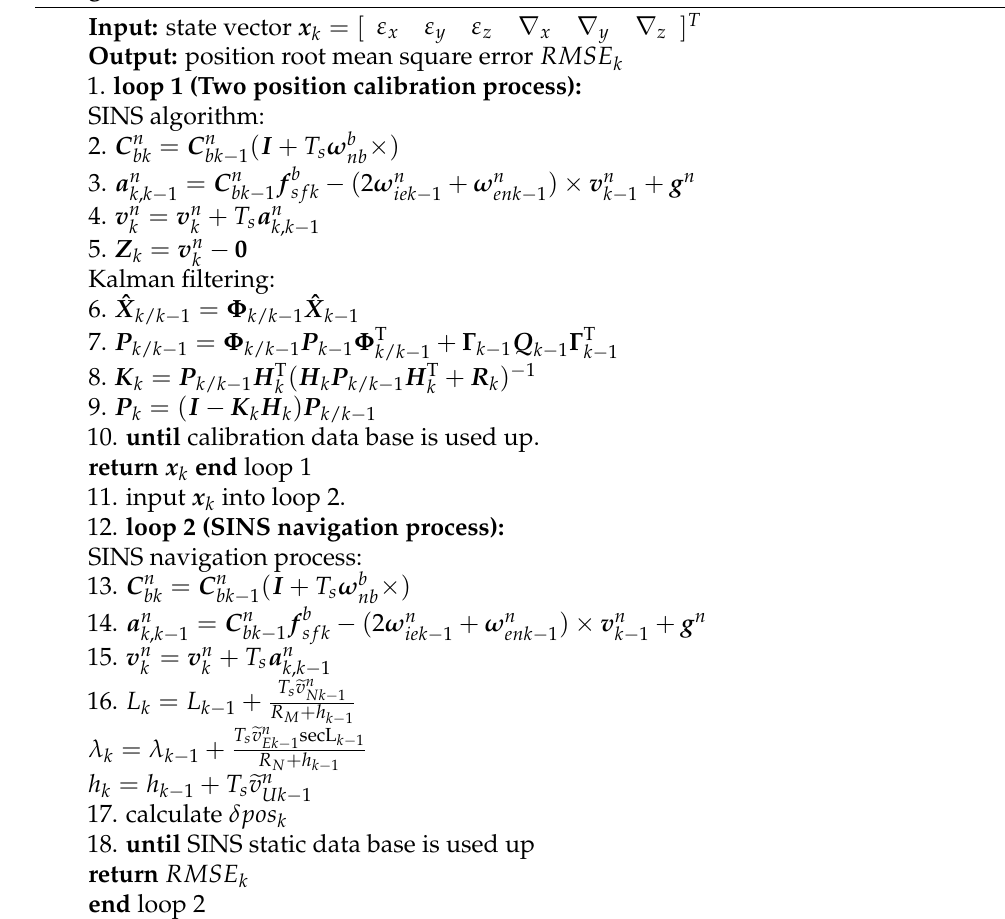
Algorithm 2: KF-based numerical